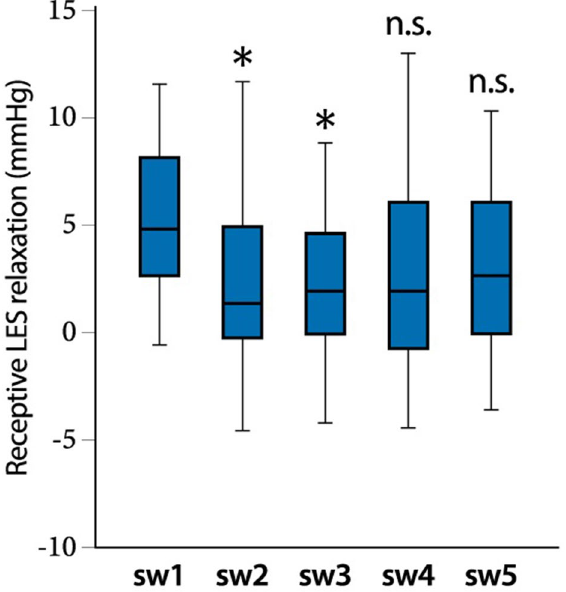
Figure 2. Receptive LES relaxation in wet swallowing. Cumulative data of receptive LES relaxation in each wet swallow from the 1st to 5th swallows. A repeated measure analysis of variance followed by Dunnett’s test was conducted, with the value of the 1st swallow (sw1) set as the control. *A statistically significant difference vs. sw1 ( p < 0.05). n.s., no significant difference vs.